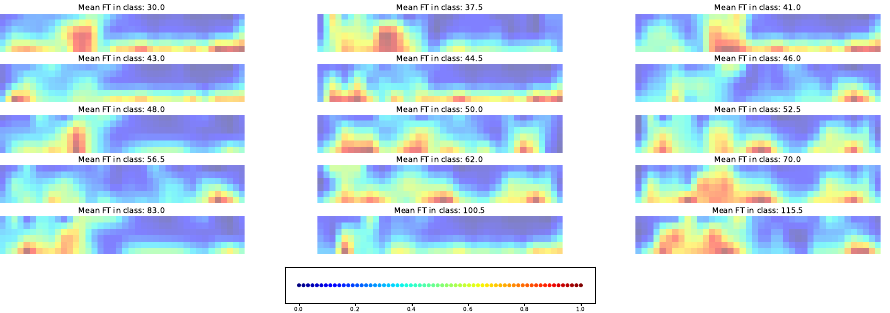
Figure 16. Example of the Score-CAM map for individual acccessions in each time class and union SNP set. Figure S7 gives the same data with higher magnification.